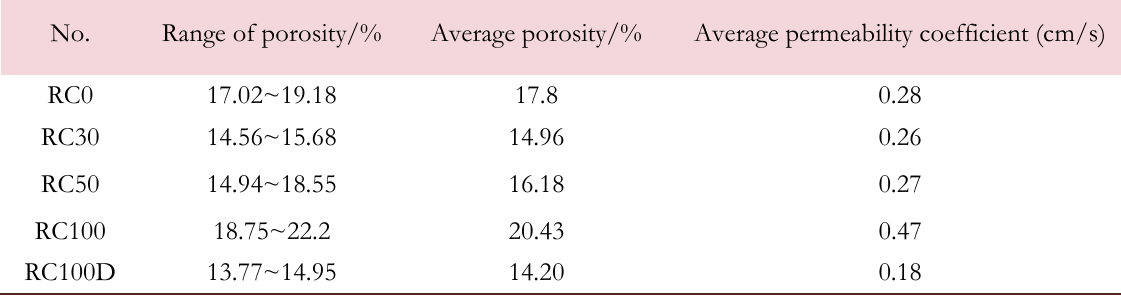
Table 4: Porosity and permeability coefficient.